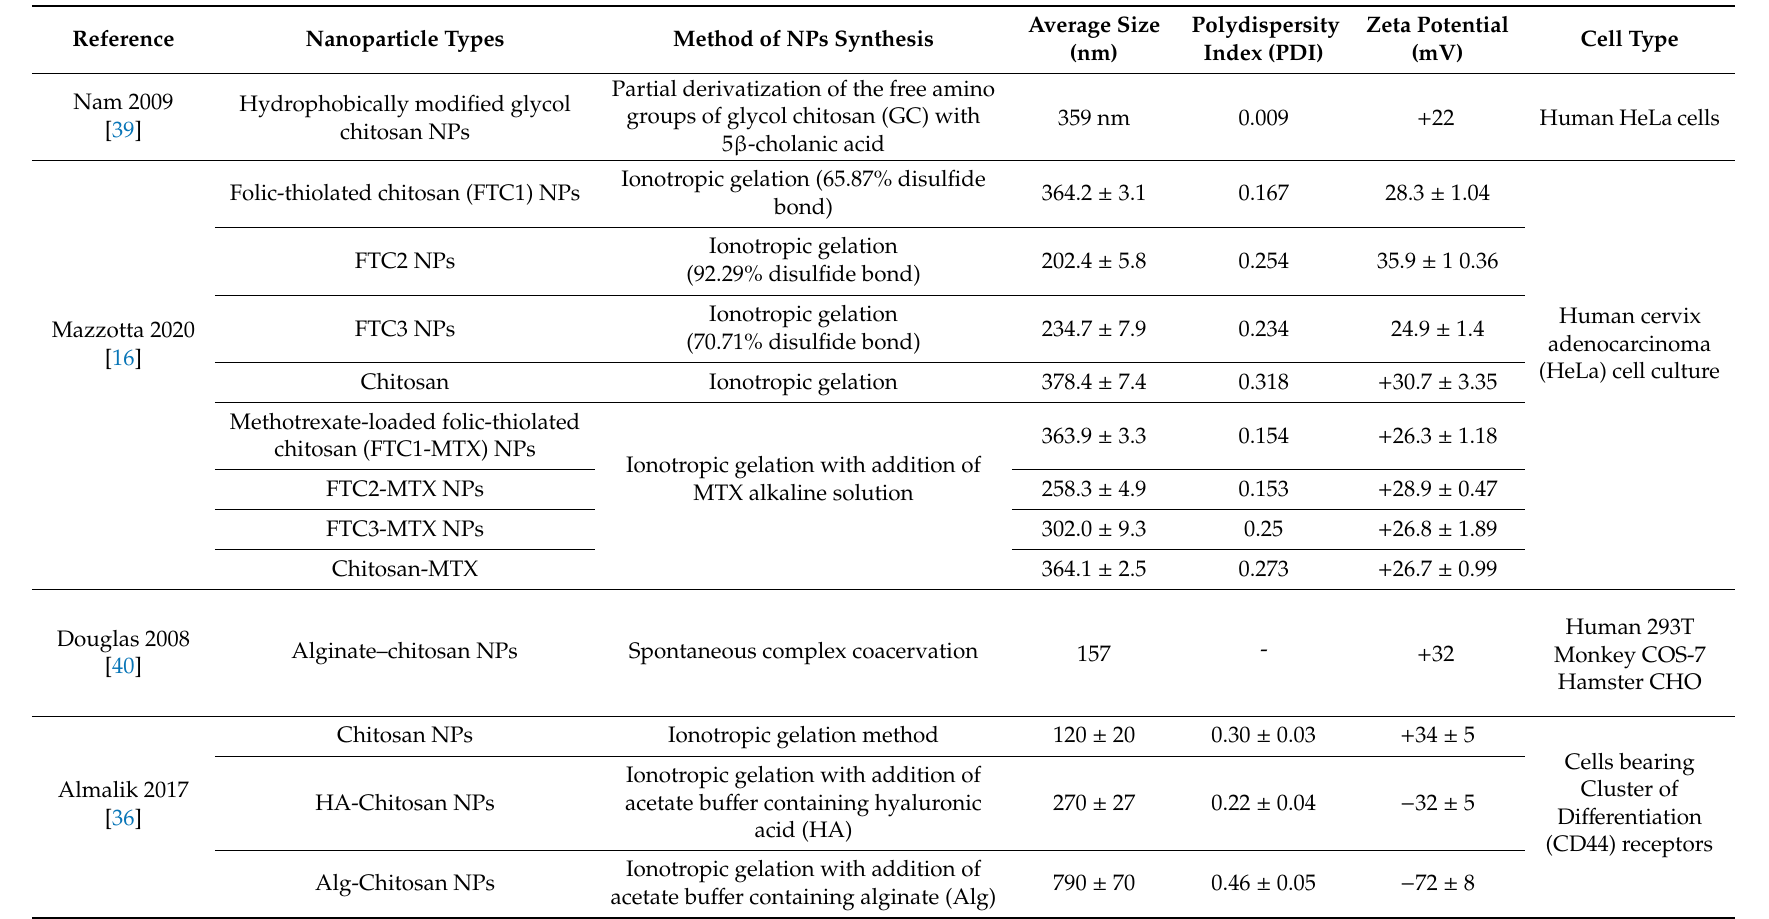
Table 1. Physico-chemical characterizations of chitosan-based NPs influencing PC formation in di ff erent cell